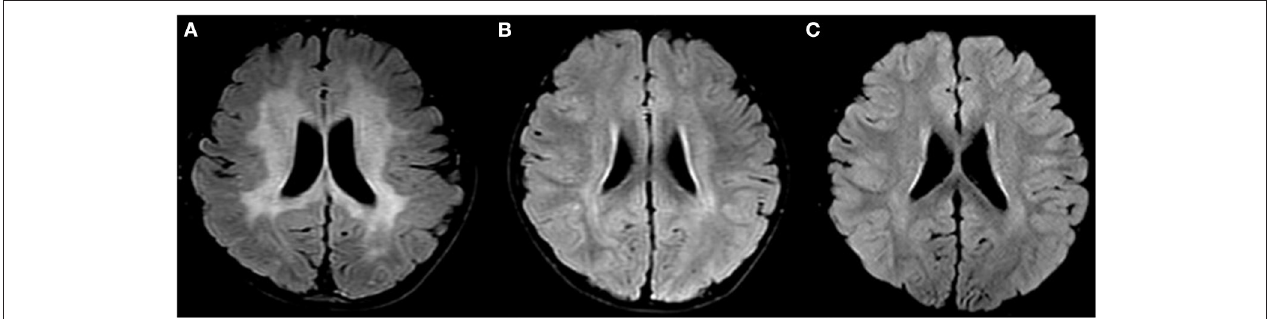
FIGURE 1 | Changes in brain MRIs associated with Zellweger syndrome. (A) Brain MRI of patient 1, A T2-weighted FLAIR image shows high signal intensity (PHILIPS MRI). (B) Brain MRI of patient 2 before transplantation. A T2-weighted TIRM shows high signal intensity (SIEMENS MRI). (C) Brain MRI of patient 2 after transplantation. A T2-TIRM shows high signal intensity (SIEMENS MRI). FLAIR, fluid-attenuated inversion recovery; TIRM, turbo inversion recovery magnitude.